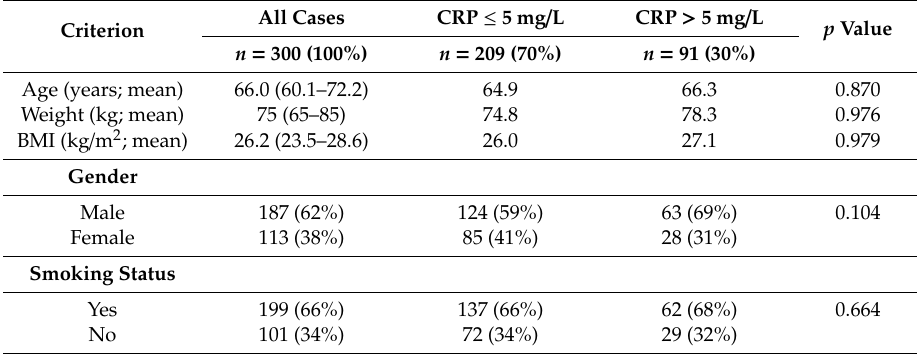
Table 3. Clinico-pathological parameters of 300 patients with stage I NSCLC after curative resection in regard to the preoperative CRP level. Abbreviations: BMI, body mass index; COPD, chronic obstructive pulmonary disease; PAD, peripheral arterial disease; CKD, chronic kidney disease; CHD, coronary heart disease; CRP, C-reactive